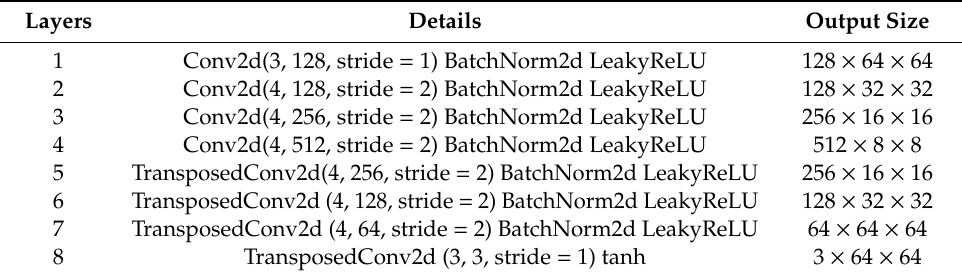
Figure 2. The model of the proposed generator network. The network takes two 3 × 64 × 64 matrices and uses the previous and the future frames as the input. The details of the parameters are listed in Table 2. Table 2. Proposed generator network’s structure.